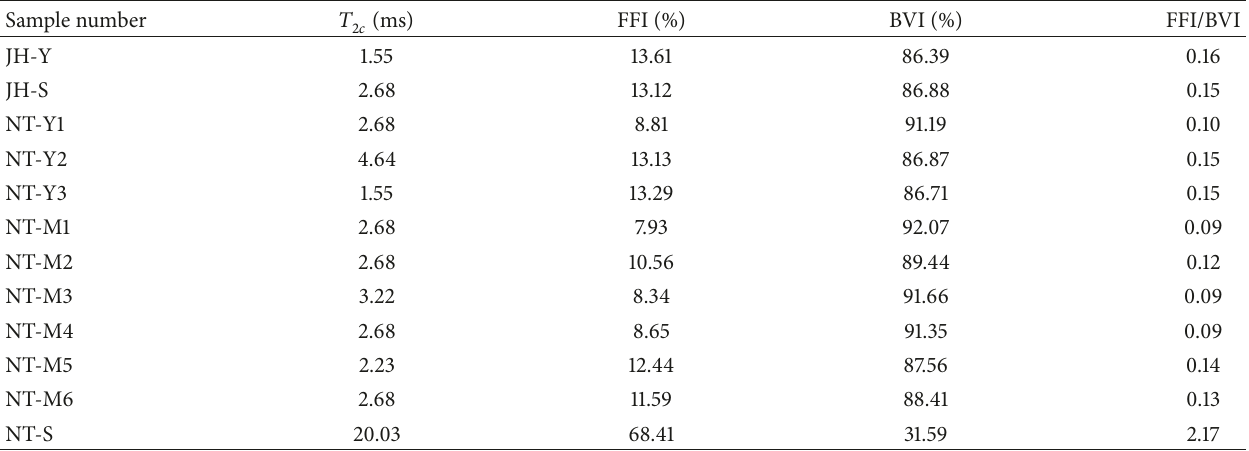
Table 5: Pore-structure parameters measured by